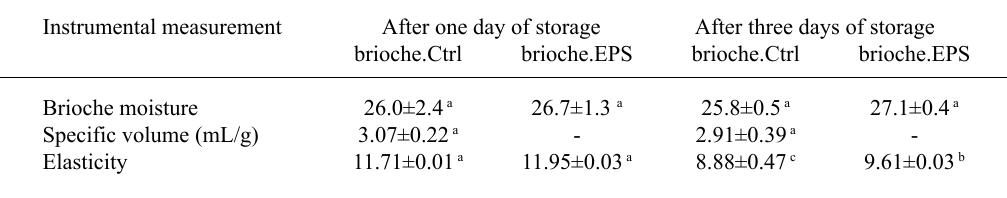
table 3. Moisture and elasticity of the two brioches, brioche.ctrl and brioche.EPS, measured after one and three days of storage, and specific volume measured at one day. The mean ± the standard deviation is expressed in %, mm and mL/g respectively for brioche moisture, elasticity and specific